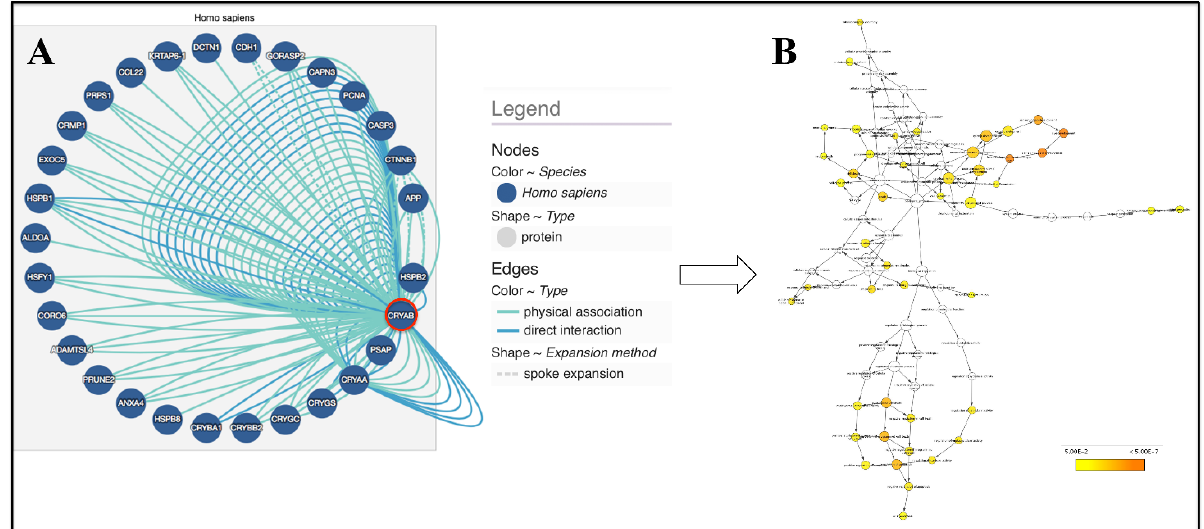
Figure 3. Schematic representation of ( A ) HSPB5 physical association/direct interaction with numerous targets and ( B ) the predominant biological functions resulting from the gene set network. Details are given in Table 2. Biological databases of protein–protein interactions (IntAct), followed by BiNGO, a plug-in of Cytoscape 3.8.2 software are used for the Gene Ontology analysis ( p < 0.01, only overrepresented categories of biological processes after correction are visualized).